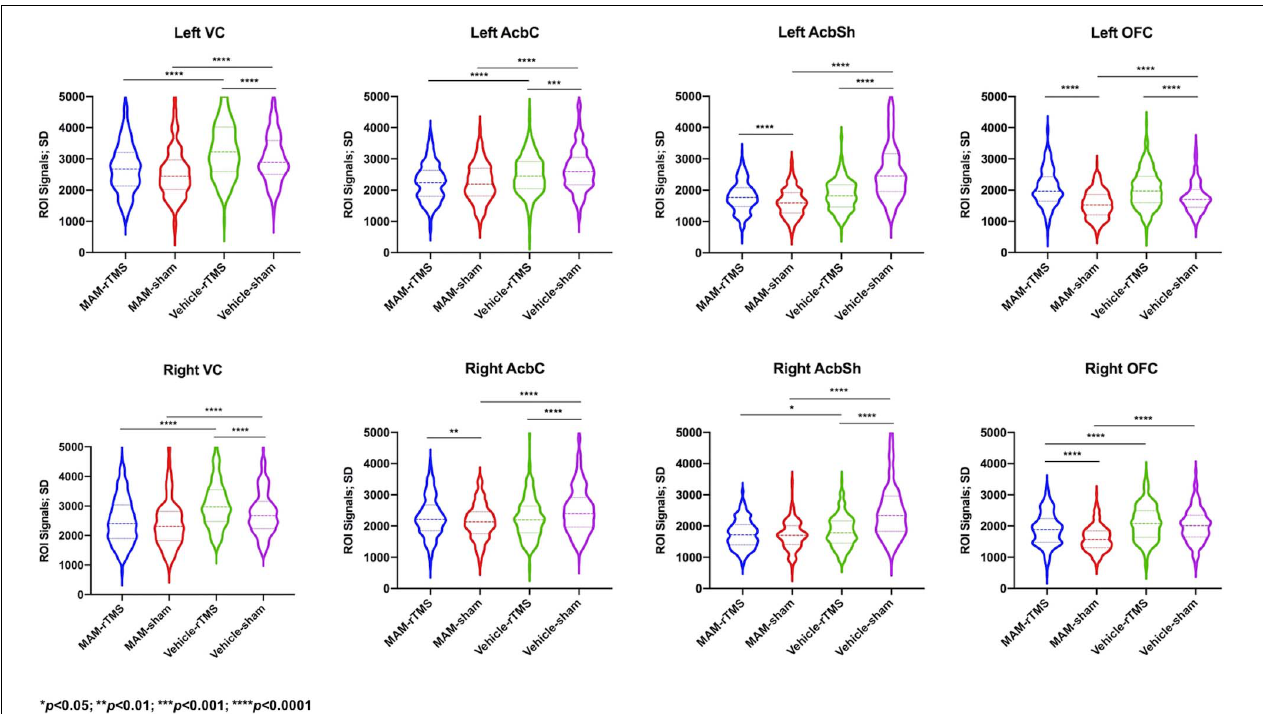
FIGURE 3 | Comparisons of standard deviation values of time series in each region of interest; SD, standard deviation; MAM, methylazoxymethanol acetate; rTMS, repetitive transcranial magnetic stimulation; VC, Visual Cortex; AcbC, Nucleus Accumbens Core; AcbSh, Nucleus Accumbens Shell; OFC, Orbitofrontal